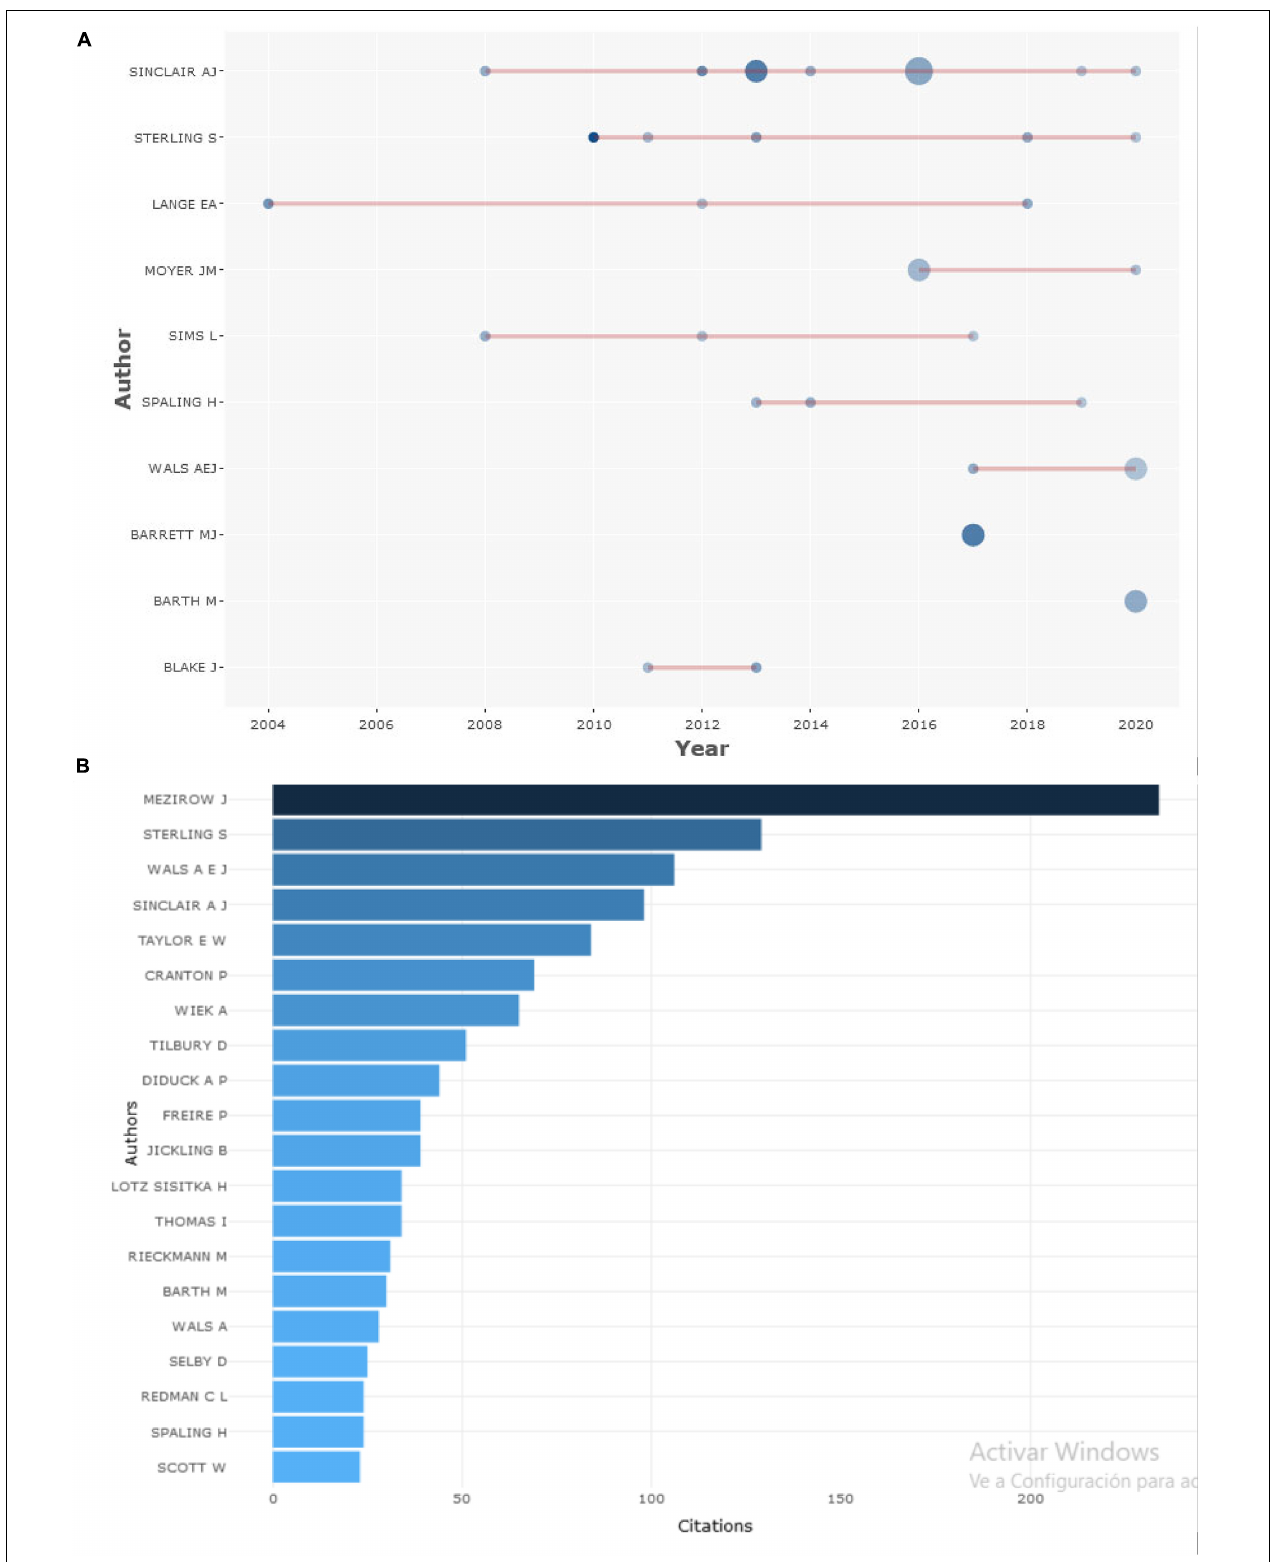
FIGURE 7 | (A) Top-authors’ production over the time, where the size of the circles represents the number of papers published that year (the larger the circle the greater the production that year) and the color represents the impact of their publications. (B) Citations per most local cited author (prepared by authors).